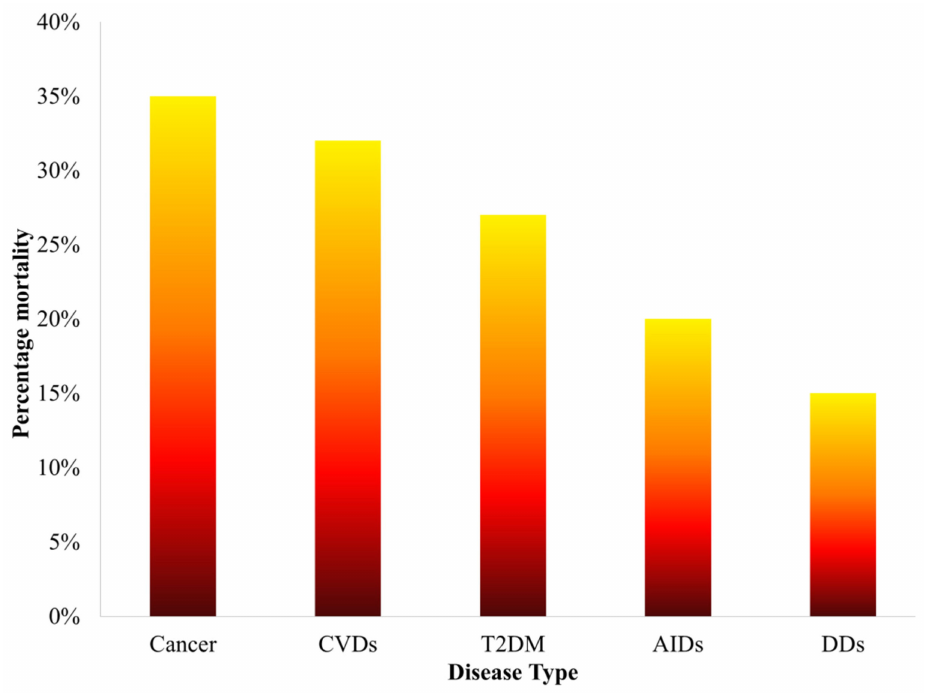
Figure 1. Statistics of percentage mortality caused by various diseases over the past five years. PPAR- γ performs the process of transcription in the nucleus after getting bound with ligand, forming a heterodimeric complex with another NHR, retinoid-X-receptor (RXR). They are locally present in cytoplasm and translocate in nucleus after the stimulation of transcription. Later, this transcriptional complex, PPAR- γ -RXR binds to the enhancer region of PPAR response elements (PPRE) that initiates the transcription of target genes